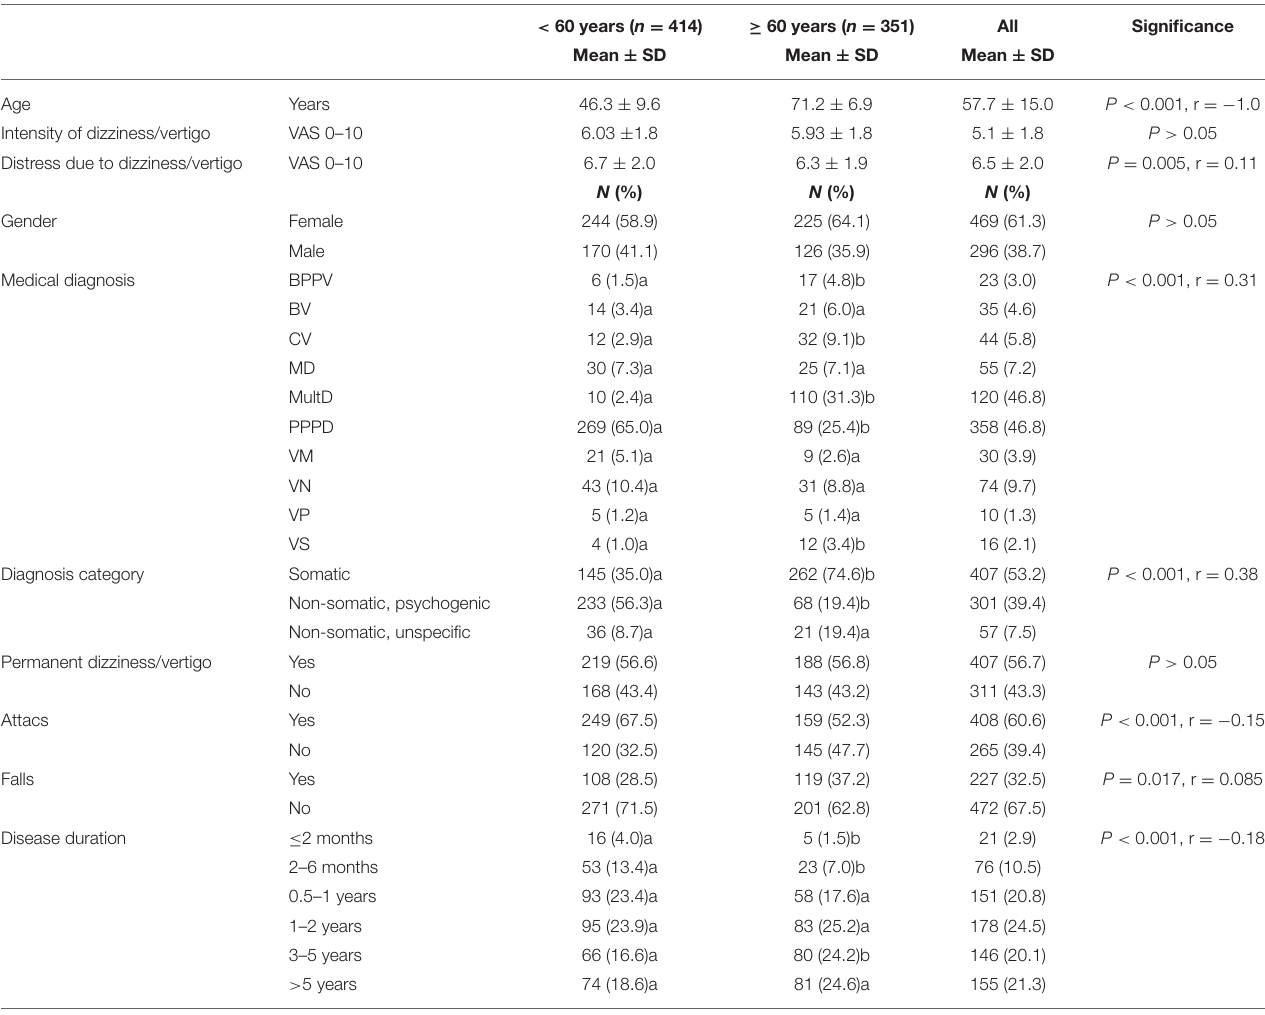
TABLE 1 | Baseline characteristics of